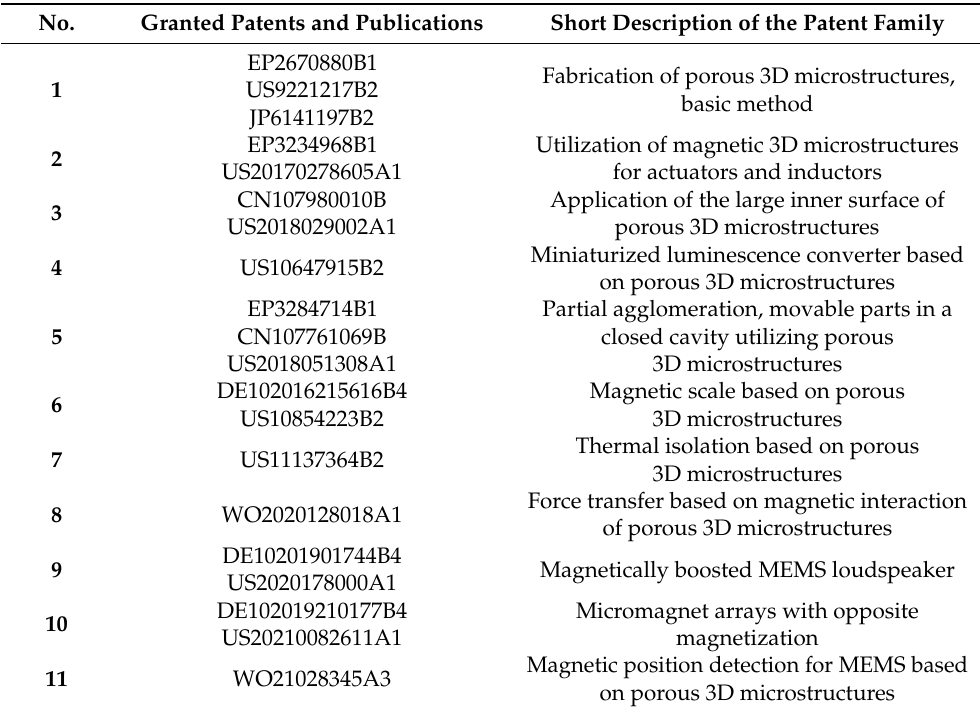
Table 2. List of granted patents and application publications related to